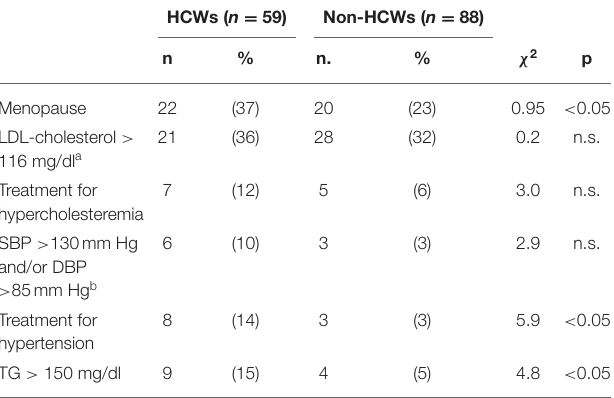
TABLE 4 | Comparison of categorical variables between the HCW and non-HCW groups.